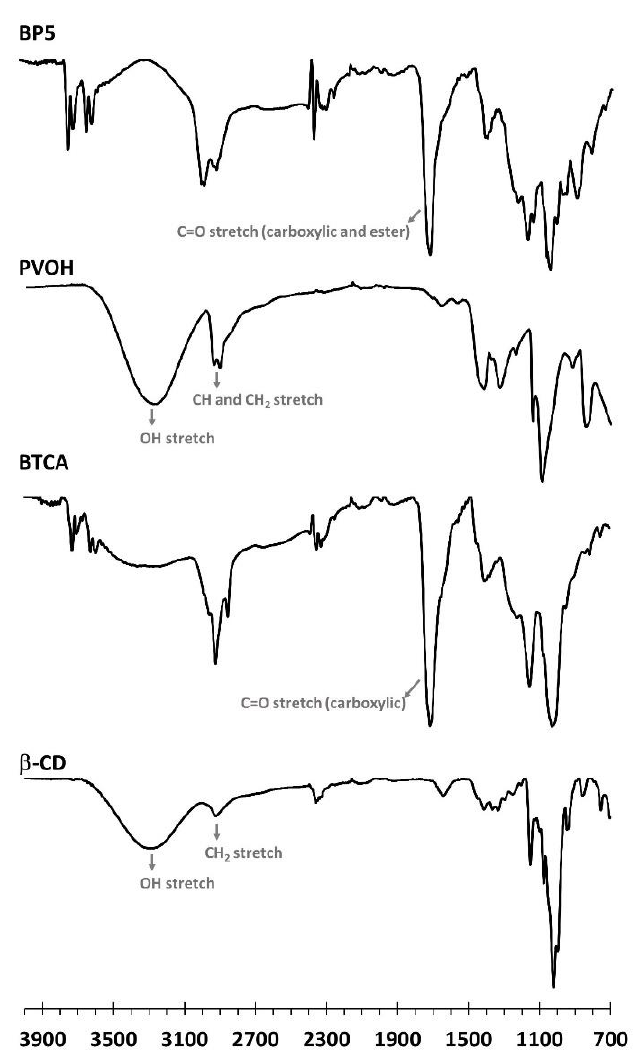
Figure 3. ATR-FTIR spectra of β -CD, BTCA, PVOH, and BP5 nanosponges.